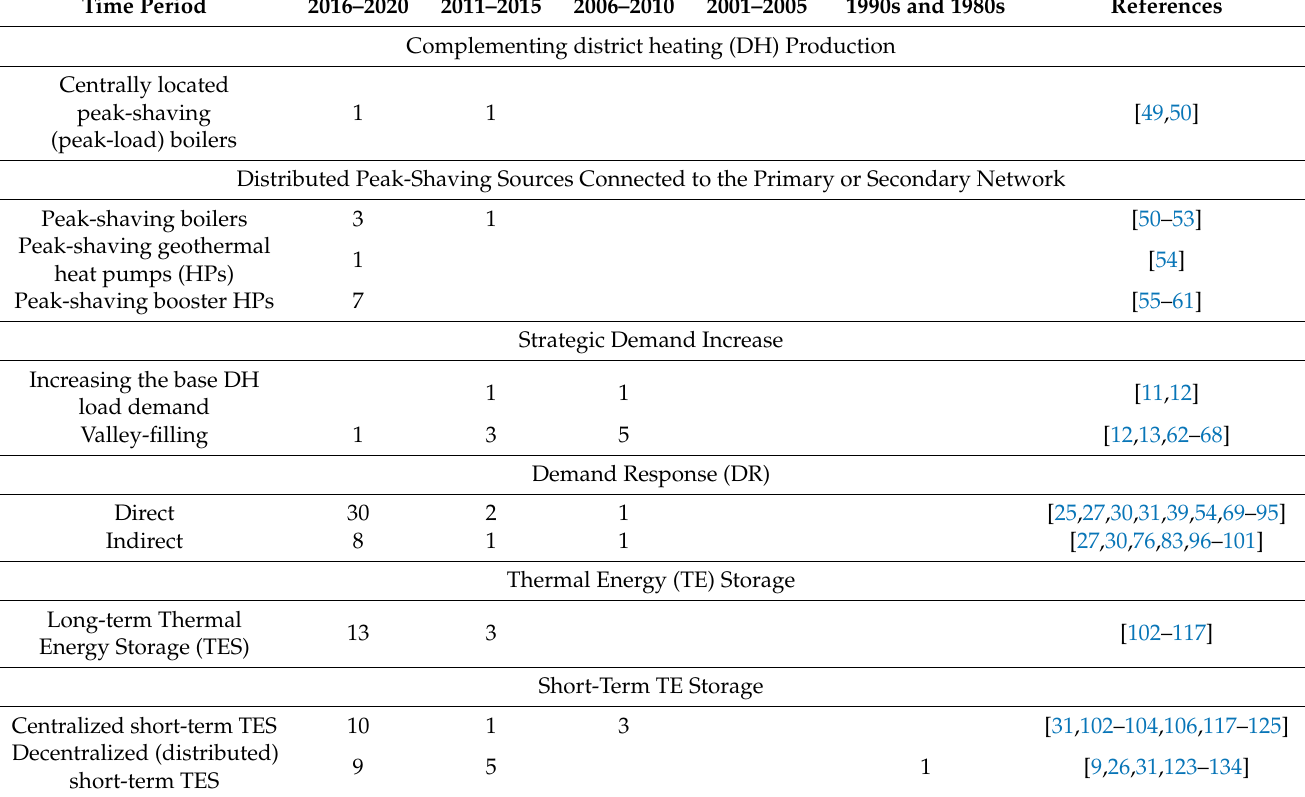
Table 2. A list of the publications per measure. Some of the studies include more than one measure. Time